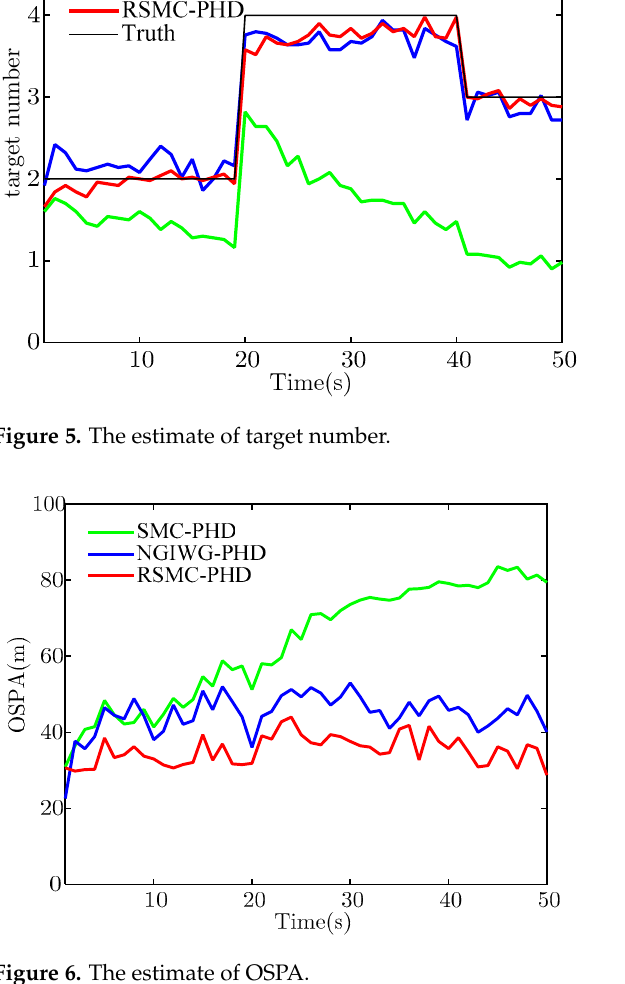
Figure 7. The MAE estimate of target number. 4